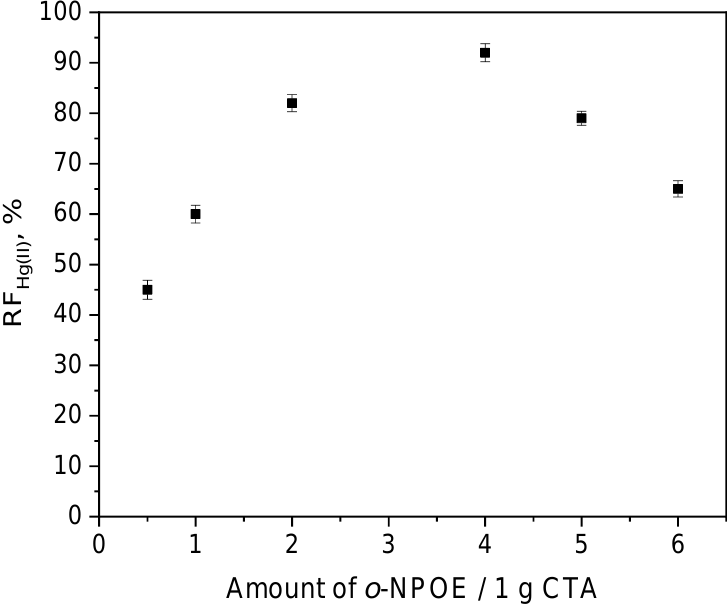
Figure 5. The effect of o -NPOE plasticizer on the recovery factor of Hg(II) transport through PIM containing KP. Source phase: 1.0 × 10 −6 M Hg(II), 0.1 M HCl; membrane: 19 wt.% of CTA, 4 wt.% of KP ; receiving phase: 0.1 M NaCl.